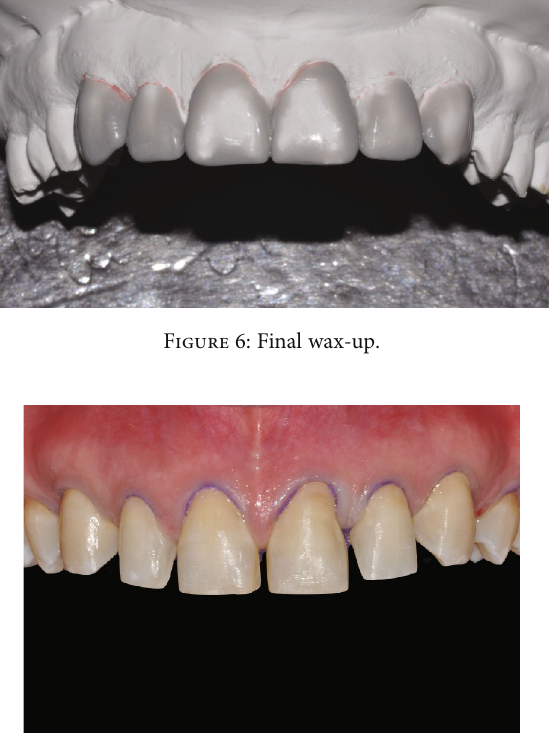
Figure 4: Orthodontic treatment plan with the Invisalign® software. On the left, the initial situation (frontal and lateral view) and, on the right, the case at the end of the orthodontic treatment.